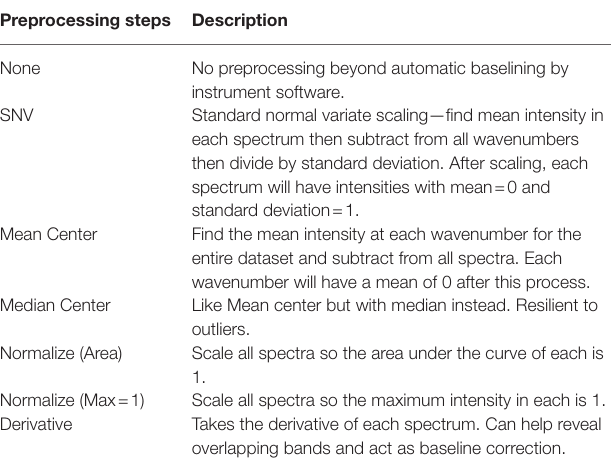
TABLE 1 | Description of preprocessing steps